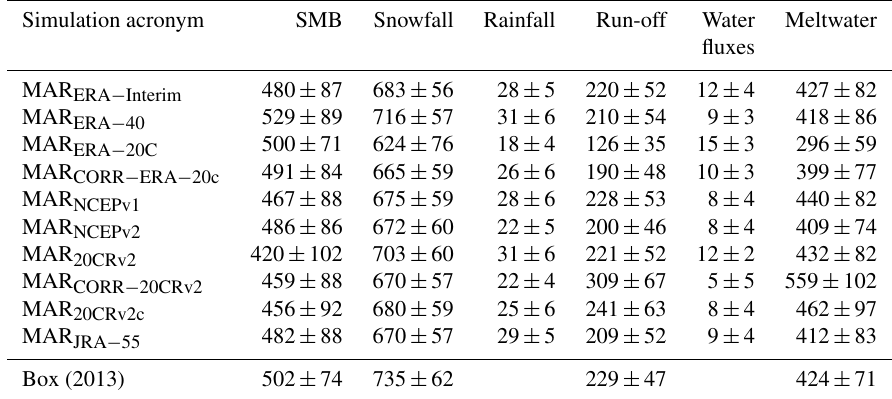
Table 1. Average and standard deviation (gauging the interannual variability) of the annual SMB components simulated by MAR over 1980– 1999 and from Box’s reconstruction (Box, 2013; interpolated to the MAR 20km grid). Units are GTyr − 1 and the acronym of each simulation (RCM forcings ) is given in the first column. The surface mass balance (SMB) equation is SMB = snowfall + rainfall − run-off − water fluxes. The run-off is the fraction of water from both surface melt and rainfall that is not refrozen before reaching the ocean. Simulation acronym SMB Snowfall Rainfall Run-off Water Meltwater